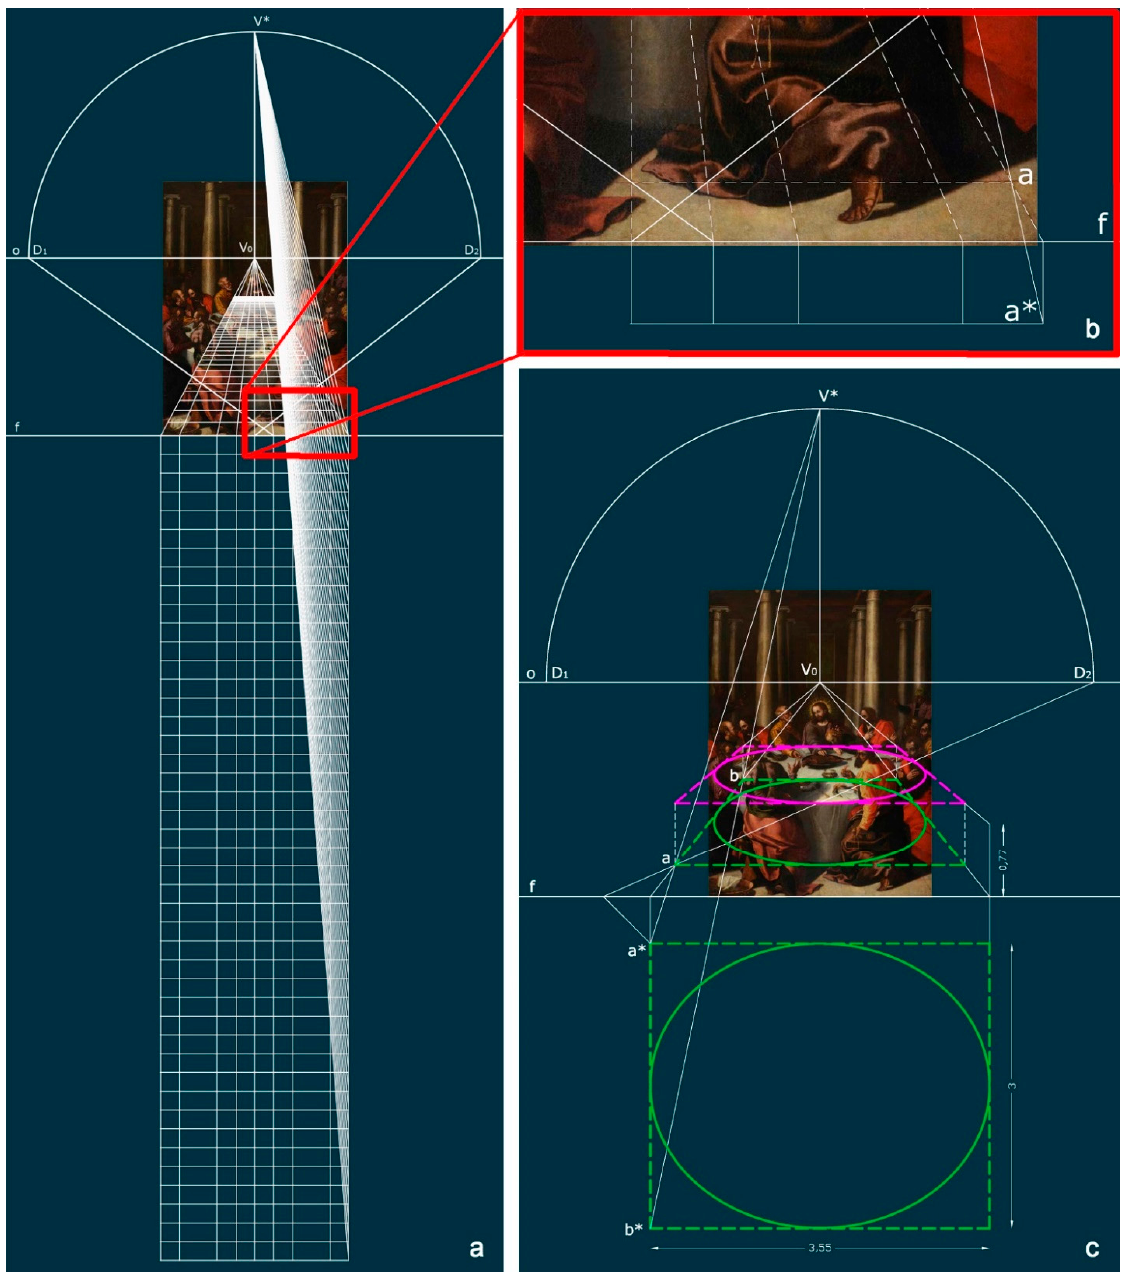
Figure 6. ( a ) Perspective rendering of the floor; ( b ) detail of visible tiles; ( c ) perspective restitution of the